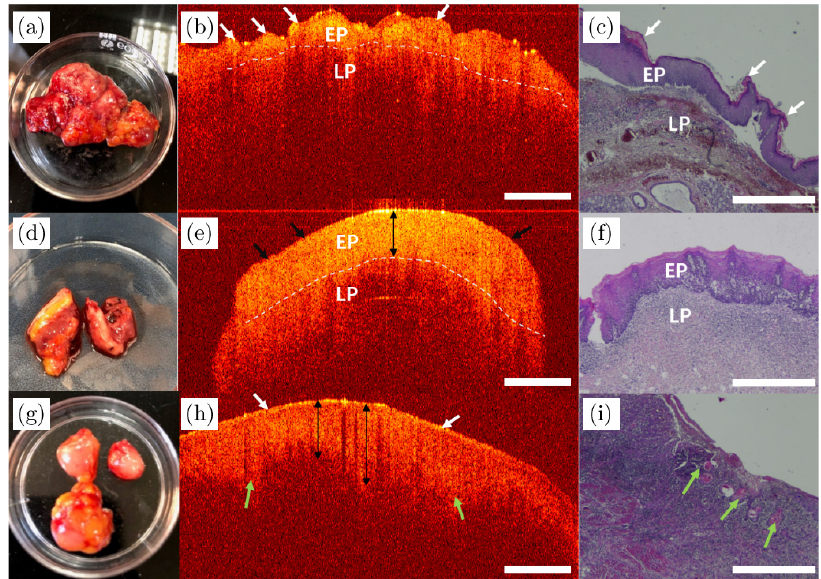
Fig. 10. OCT images and their histopathological images of leukoplakia. Panels (a) and (d) are photos, and panels (b) and (e) are the 2D OCT images of leukoplakia from two patients, respectively. Panel (g) is the photo and panel (h) is the 2D OCT image of leukoplakia canceration. Panels (c), (f) and (i) are the corresponding histopathological images of panels (a), (d) and (g), respec- tively. EP: epithelial layer and LP: lamina propria.